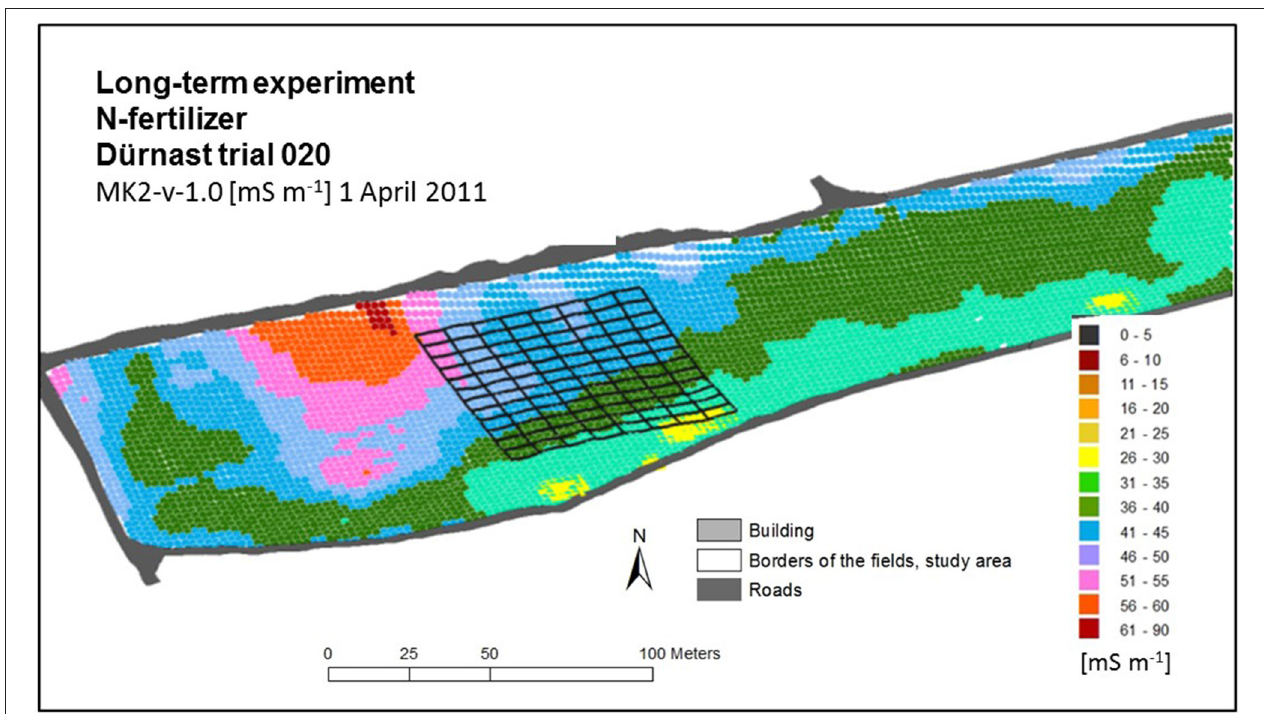
FIGURE 5 | 3-dimemsial map of interpolated EC a readings [mS m − 1 ] in a 2.m grid measured with MK2-v-1.0 and the borders of field